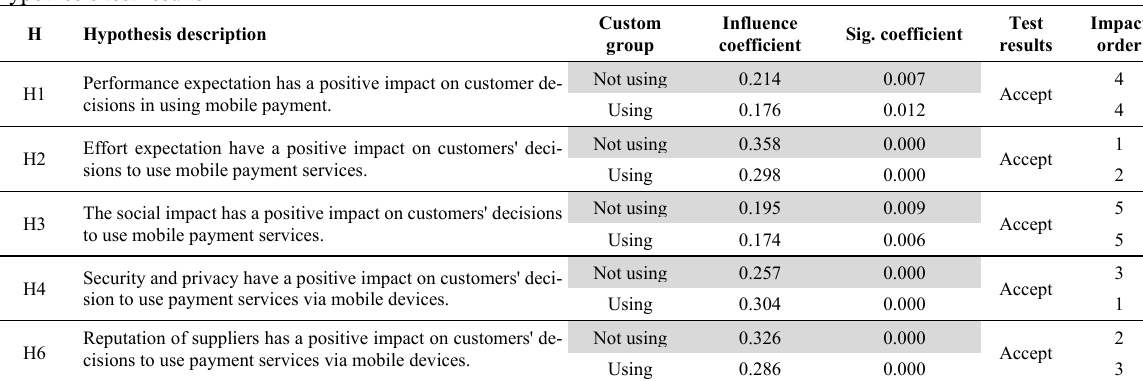
Hypothesis test